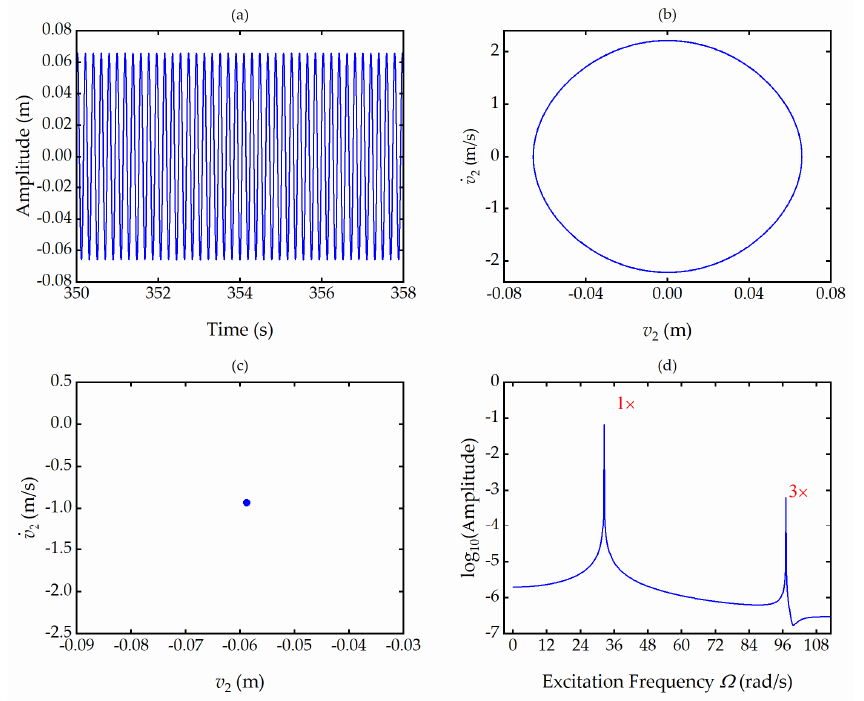
Figure 12. Response of a system with only third − order nonlinear terms for the case of w 0 = 0.0008 m, Ω = 32.34 rad/s: ( a ) Time history of steady state. ( b ) Phase portrait. ( c ) Poincare map. ( d ) Spectrum response.